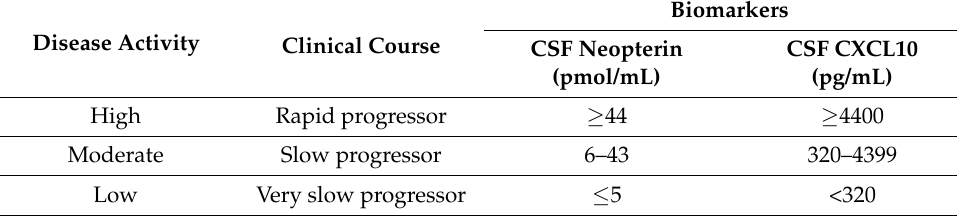
Table 4. Classification criteria for disease activity [80].